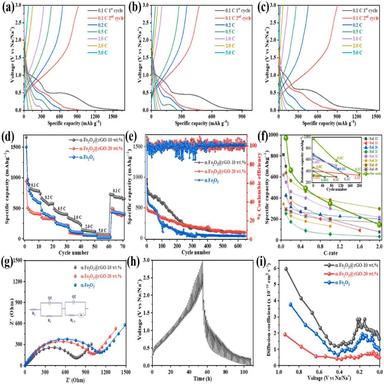
(a–c) GCD plots of α-Fe2O3@rGO-10 wt%, α-Fe2O3@rGO-20 wt%, and α-Fe2O3 at various C-rates, respectively, (d) rate capability, (e) cyclic stability at 0.1 Crate, (f) comparison of specific capacity and rate capability of α-Fe2O3@rGO-10 wt% sample with a reported Fe2O3/rGO materials (inset shows the comparison of retention capacity after cyclic stability), (g) EIS spectra at 650th cycle of α-Fe2O3 and α-Fe2O3@rGO core@shell nanocubes (corresponding lines are indicating fitting curves); inset shows the corresp